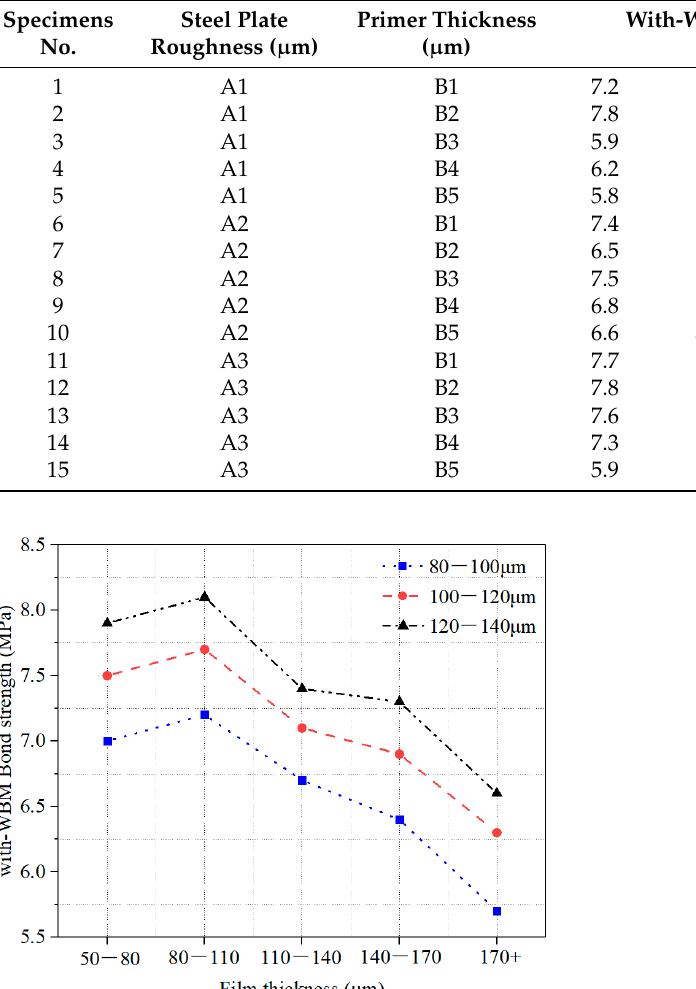
Table 14. Bond strengths of the with-WBM specimens.